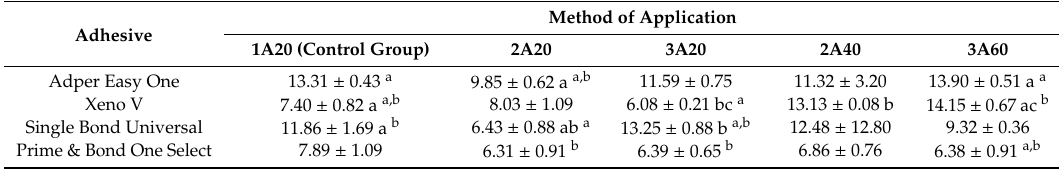
Within tested adhesives, means followed by the same lowercase letters in row and superscript letters in column indicate significant statistical di ff